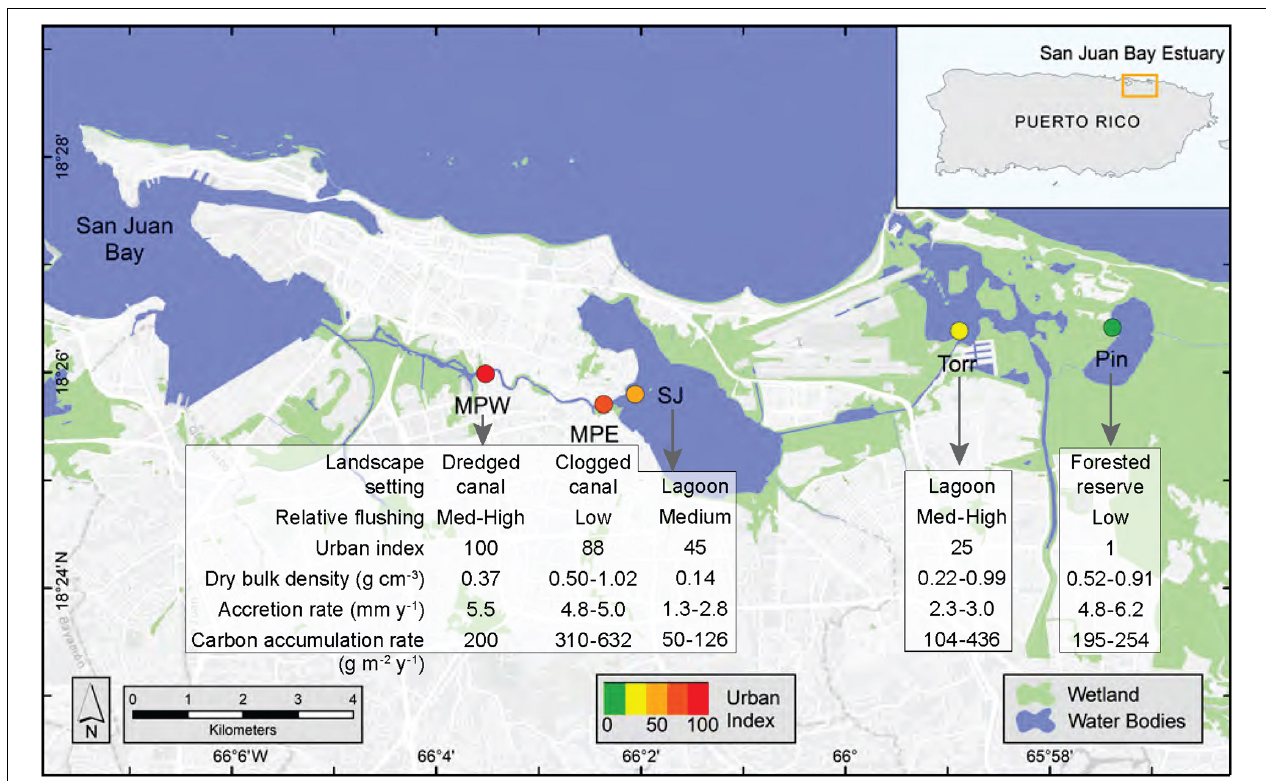
FIGURE 1 | Map of San Juan Bay Estuary with study sites, urban index (colored circles), landscape setting, relative tidal flushing, and mangrove soil characteristics. The Urban Index was scored on a scale from 1 to 100 and based on surrounding coverage of mangrove wetland, non-mangrove vegetation, open water, urban land, population density, and road density, which were determined in a 500 m buffer from the approximate center of the study site. National Wetland Inventory data were used to depict wetlands, which included estuarine and marine, freshwater emergent, and freshwater forested/shrub wetlands (U.S. Fish and Wildlife Service, 2018). Tidal flushing and mangrove soil characteristics were based on previously published data (Branoff, 2020a; Eagle et al., 2021; Wigand et al., 2021); see Table 1 for site